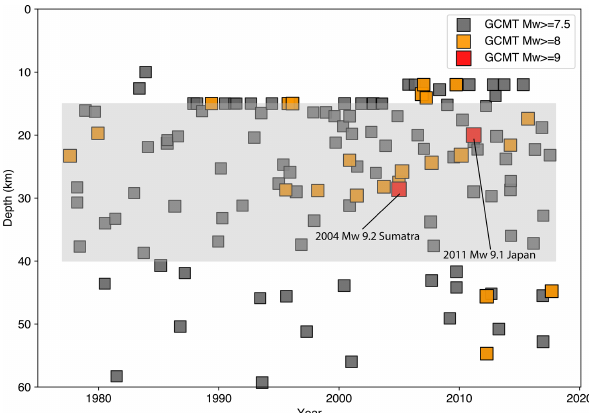
Figure 4. Depth distribution of the seismicity in the Manila sub- duction zone between 1970 and 2018. This data set is downloaded from the GCMT catalog. Colors represent the seismic moment mag- nitude. The giant 2004 Sumatra and 2011 Japan earthquakes are highlighted in the